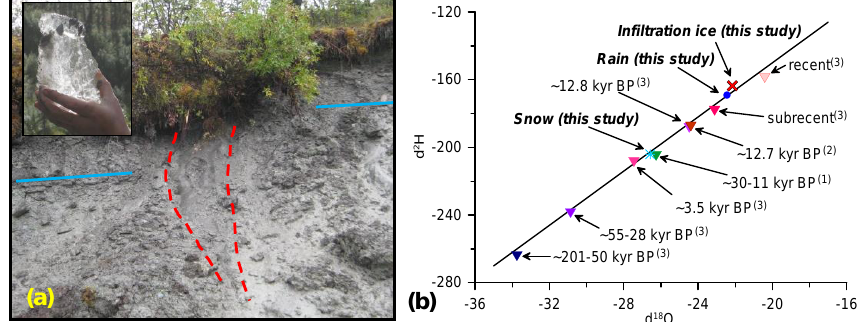
Figure 4. Infiltration ice in FDL-A. (a) Massive ice (outlined by red dashed lines) exposed in RTS along the left flank in August 2014 (see Fig. 2a for location). Offset buried organic layers are indicated by solid blue lines; inset shows an example of clear infiltration ice. (b) Isotope analysis results; the GMWL is plotted for comparison. Upside-down triangle symbols represent wedge ice sample values; values taken from the literature are from Douglas et al. (2011) ( 1 ) and Meyer et al. (2010 ( 2 ) , 2002 ( 3 )